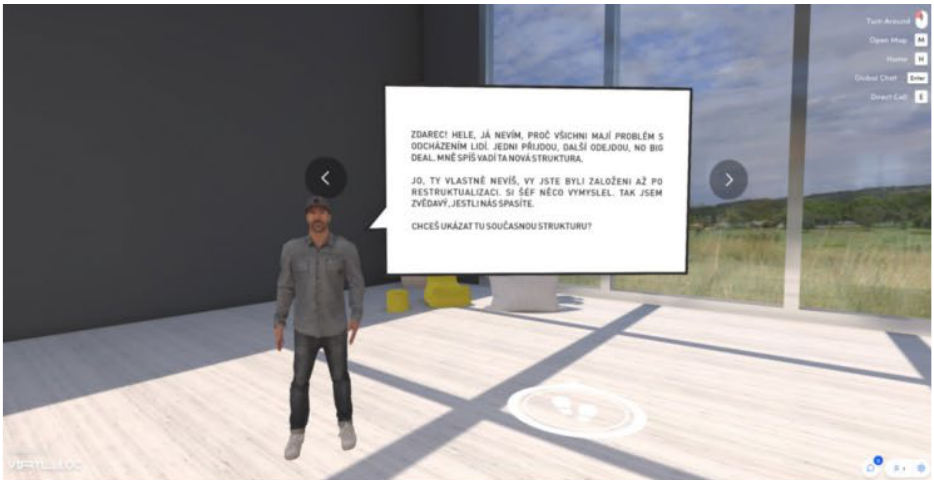
Figure 1. Avatar giving a suggestion to the